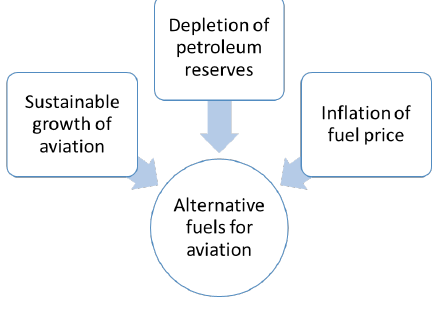
Figure 5. Motivation of alternative fuels for aviation.